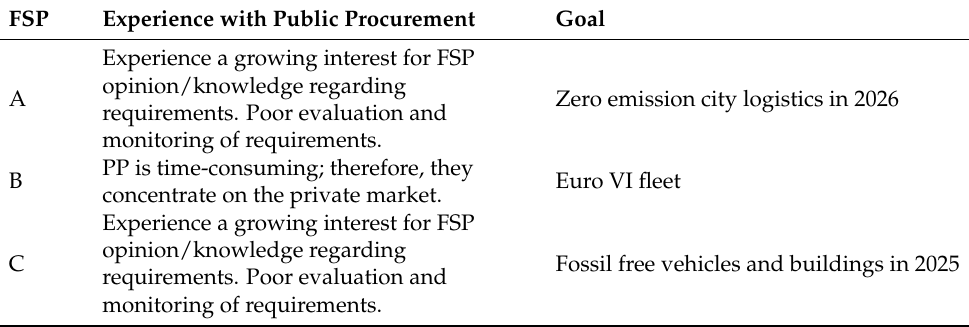
Table 11. Findings from interviews with freight service providers.